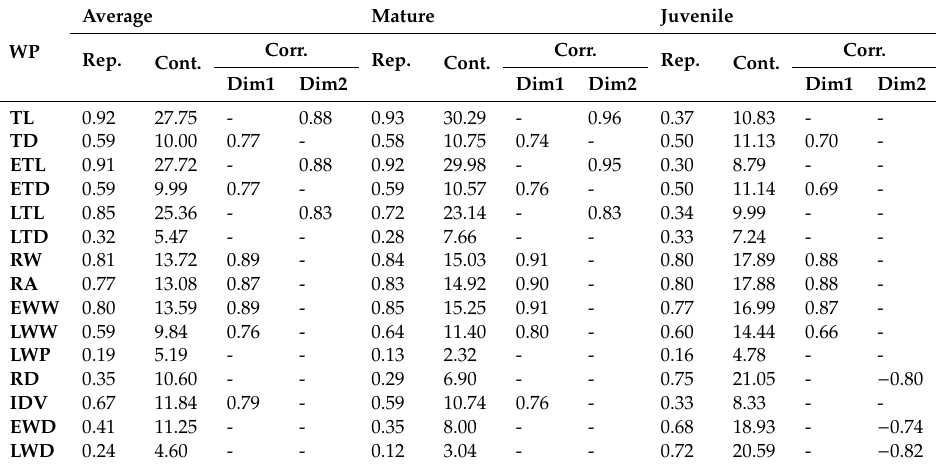
Figure 4. Inter-ring radial variations of the intra-ring density variation (IDV). Bars indicate standard errors of the mean. Table 3. Quality of the representation, contribution to the axis, and correlation with the axis of the radial growth-related properties, anatomical properties, and density-related properties for the whole ring, earlywood zone, latewood zone, whole pith-to-bark radial section, juvenile wood zone, and mature wood